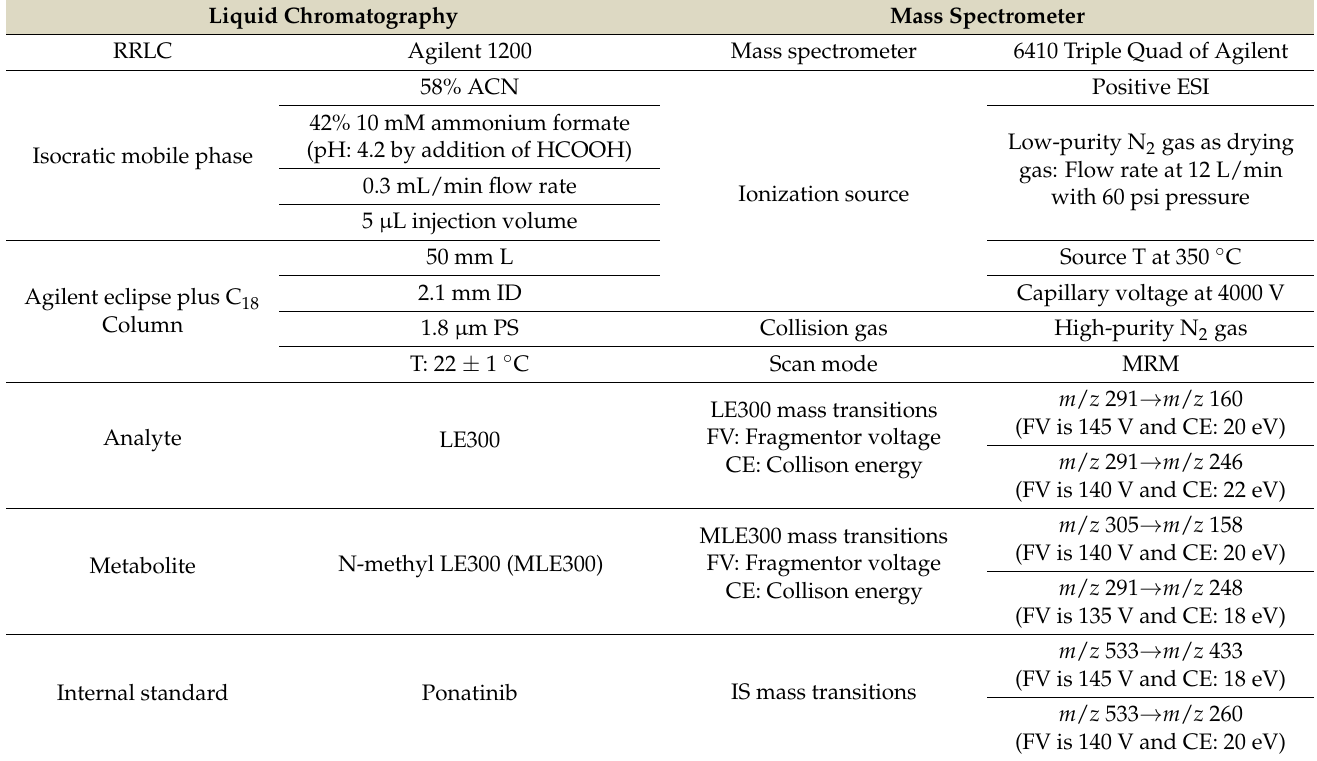
Table 9. LC-MS/MS